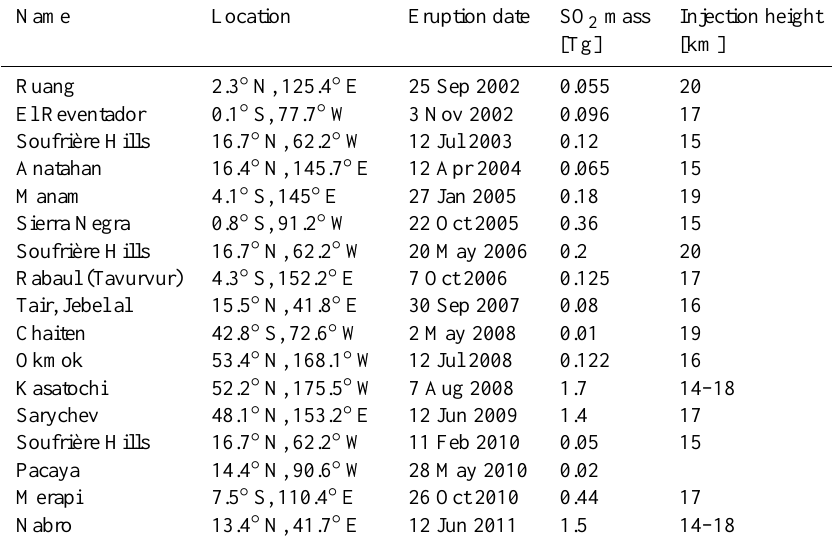
Table 2. Major volcanic eruptions in the time period of the MIPAS measurements. General data of volcanoes are from http://www.volcano.si. edu. Injection heights and SO 2 masses are based on Neely et al. (2013, Table S1) and references therein. References for additional eruptions: Soufrière Hills on 12 July 2003, Carn and Prata (2010); Soufrière Hills on 11 February 2010, Cole et al. (2010); Nabro mass, Clarisse et al. (2012); Nabro injection height, Bourassa et al. (2012) and connected discussion (Fromm et al., 2013; Vernier et al., 2013; Bourassa et al., 2013); Merapi, Surono et al. (2012). In the case of Pacaya, the SO 2 mass is taken from Aura/OMI measurements on 30 May 2010